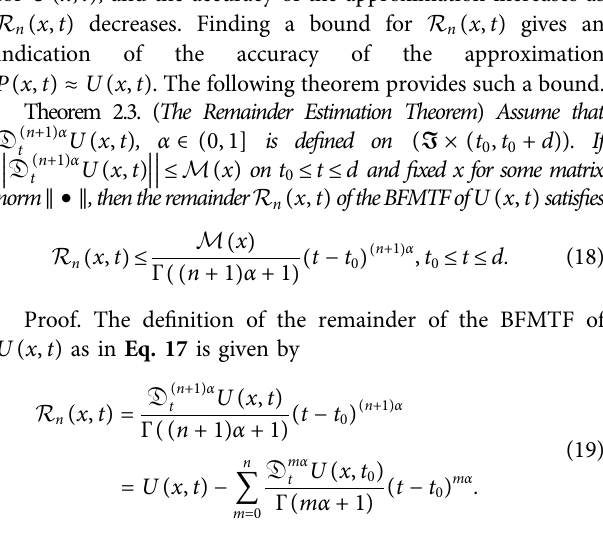
Frontiers in Physics |